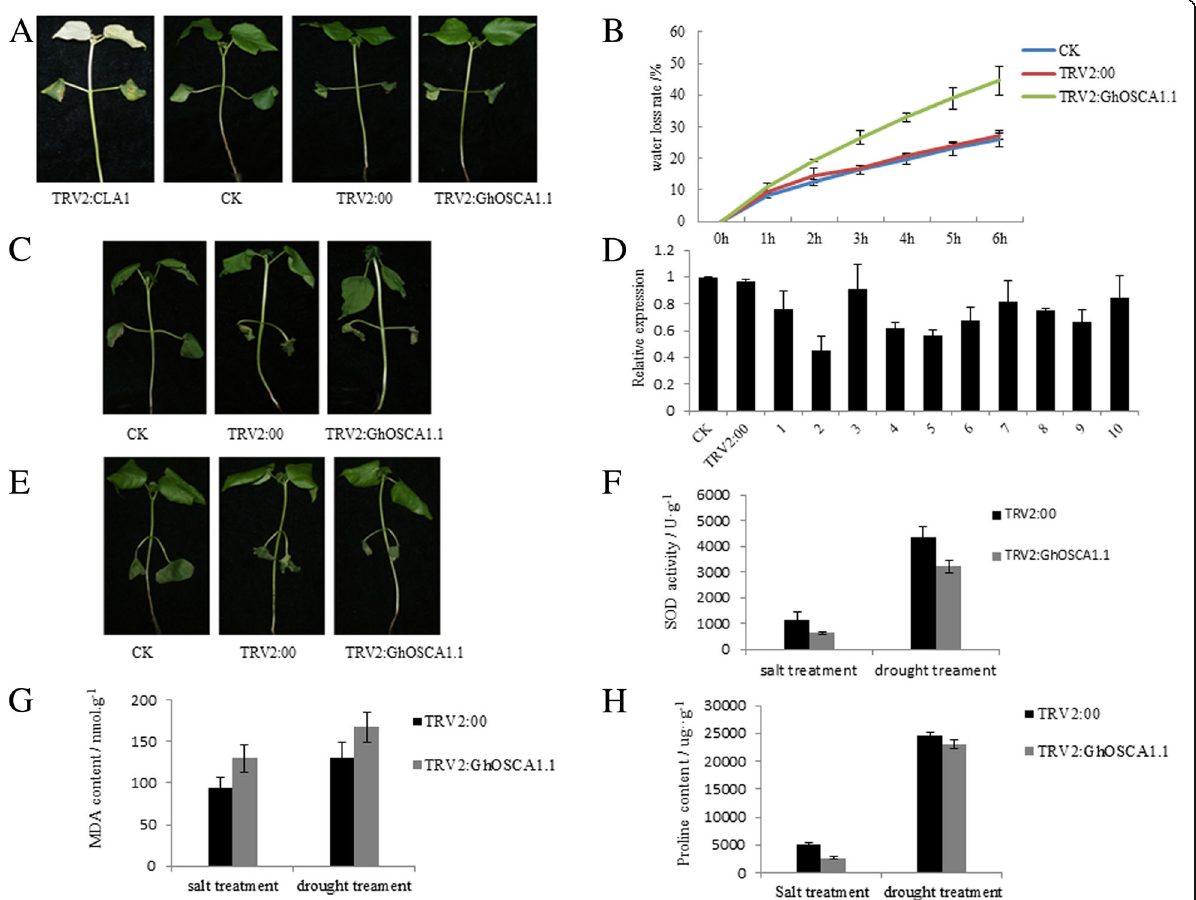
Fig. 8 VIGS validates the function of GhOSCA1.1 gene. a: The phenotypes of TRV2:CLA1, CK, TRV2:00 and TRV2: GhOSCA1.1 seedlings, b: The water loss rate of CK, TRV2:00 and TRV2: GhOSCA1.1 seedlings. c: the phenotypes of CK, TRV2:00 and TRV2:GhOSCA1.1 seedlings were observed 48 h after 17%PEG treatment. d: The silencing efficiency of GhOSCA1.1 gene in seedlings. e: The phenotypes of CK, TRV2:00 and TRV2: GhOSCA1.1 seedlings were observed 48 h after salt stress treatment. f: The activity of SOD in TRV2:00 and TRV2: GhOSCA1.1 seedlings after salt and drought stress treatment. g: The contents of MDA in TRV2:00 and TRV2: GhOSCA1.1 seedlings after salt and drought stress treatment. h: The contents of PRO in TRV2:00 and TRV2: GhOSCA1.1 seedlings after salt and drought stress